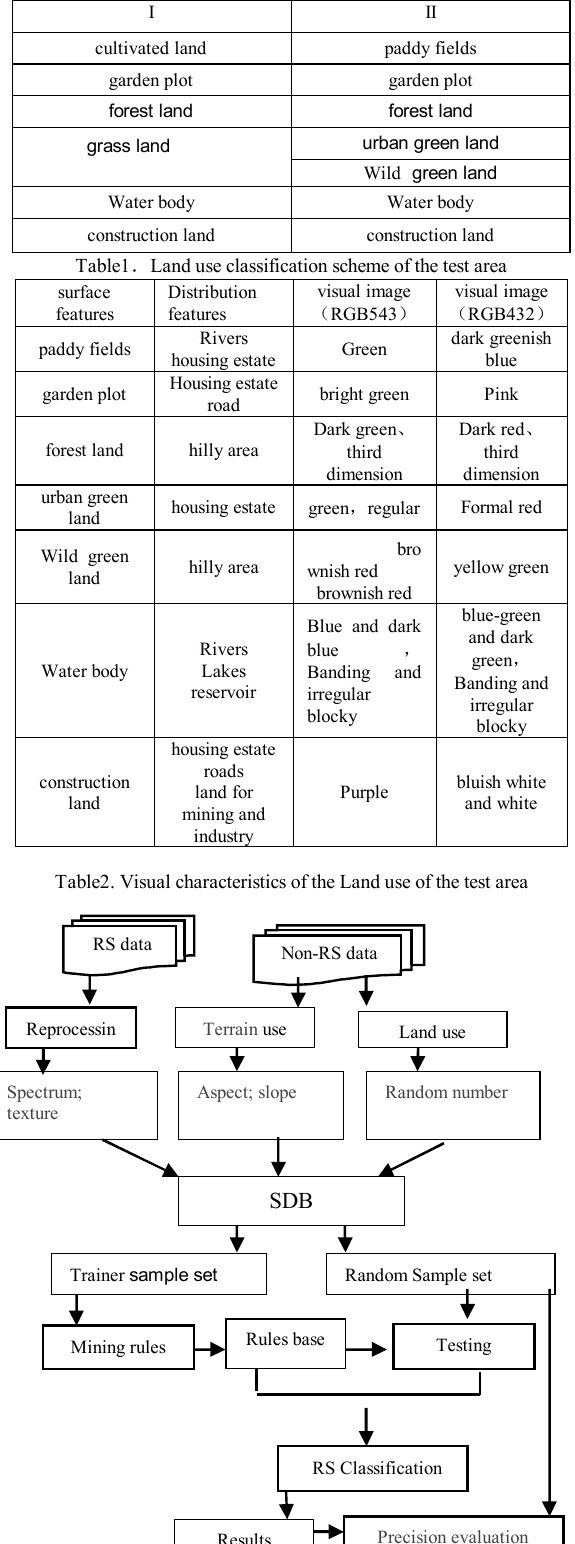
Figure1. Relative locations of study area